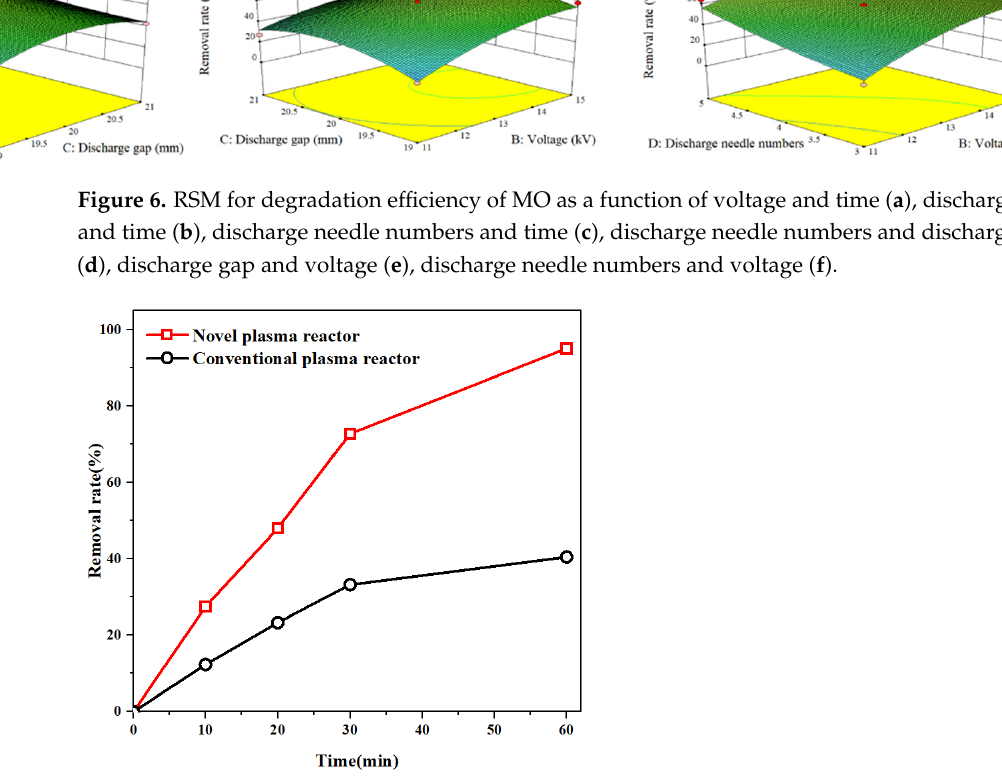
Figure 7. The comparison of novel and conventional reactor for the removal rates of MO (the novel plasma reactor (V = 50 mL) and the conventional plasma reactor (V = 150 mL) under the same conditions of initial concentration = 100 mg/L, voltage = 15 kV, discharge gap = 20 mm, and discharge needle numbers = 5).